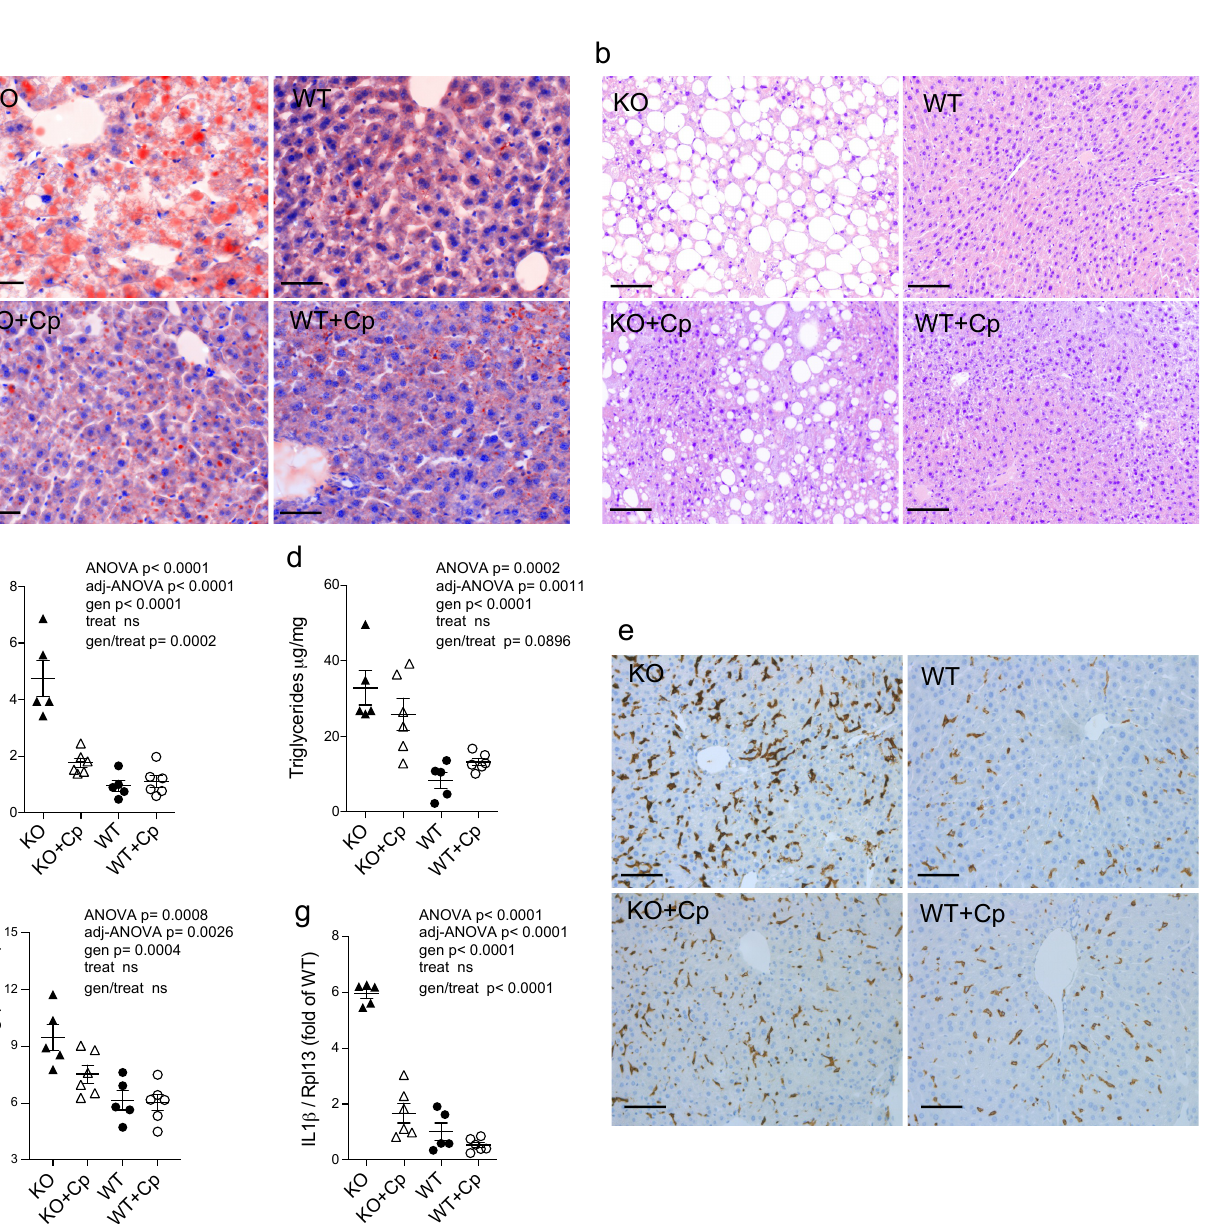
Figure 3. CpKO mice show liver steatosis and macrophage infiltration, which are reduced by Cp administration. ( a ) Oil Red O staining of liver cryostat sections (14 µ m-thick) from mice at 10 months of age after 2 months of treatment with an intraperitoneal injection of Cp 5 µ g/g, administered every 5 days (KO+Cp; WT+Cp) or saline (KO, WT). ( b ) Histological liver paraffin sections (3 µ m-thick) stained by hematoxylin-eosin evidenced of mice as in ( a ). ( c ) Quantitation of lipids droplets deter- mined as a percentage of area occupied by Oil Red O staining in the liver sections of mice treated as in ( a ), images were acquired with Nuance FX Multispectral tissue imaging system and analyzed with Im- ageJ software. ( d ) Triglycerides concentration in the liver homogenates from mice of different groups was measured by an Enzyme Chrome triglyceride assay kit. ( e ) Staining for the F4/80 macrophages and Kupffer cells marker (brown) in the liver paraffin sections (3 µ m-thick); cell nuclei, blue staining. ( f ) Quantitation of the F4/80 staining analyzed using QuPath software. ( g ) Quantitative real-time PCR analysis for IL1ß mRNA in the liver of mice; values were normalized to ribosomal protein L13a ( Rpl13 ) mRNA expression and reported as a proportion of the WT value. Data: mean ± SEM of animal Figure 3 R2 scomponibile groups, each dot corresponds to one animal (CpKO, WT n = 5; CpKO+Cp, WT+Cp, n = 6); statistical p -values were evaluated by two-ways ANOVA and reported as value for overall ANOVA, value for Benjamini-Hochberg adjustment for multiple ANOVA tests related to liver features (adj-ANOVA), for genotype variable (gen), for treatment variable (treat) and for the interaction of genotype/treatment (gen/treat). Scale bars = 50 µ m in ( a ), and 100 µ m in ( b , e